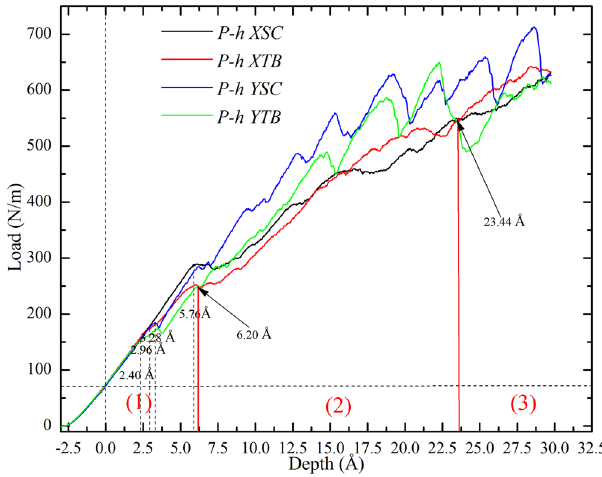
Figure 2. Indentation load-depth ( P-h ) curves of four